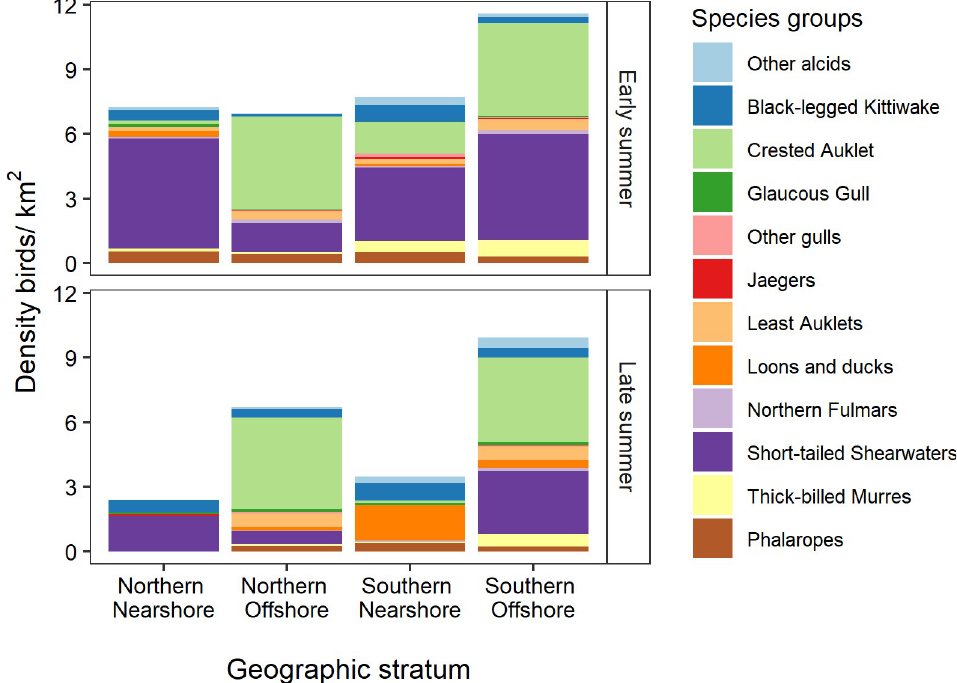
Fig 6. Species composition of seabird community in geographic strata of the northeastern Chukchi Sea,